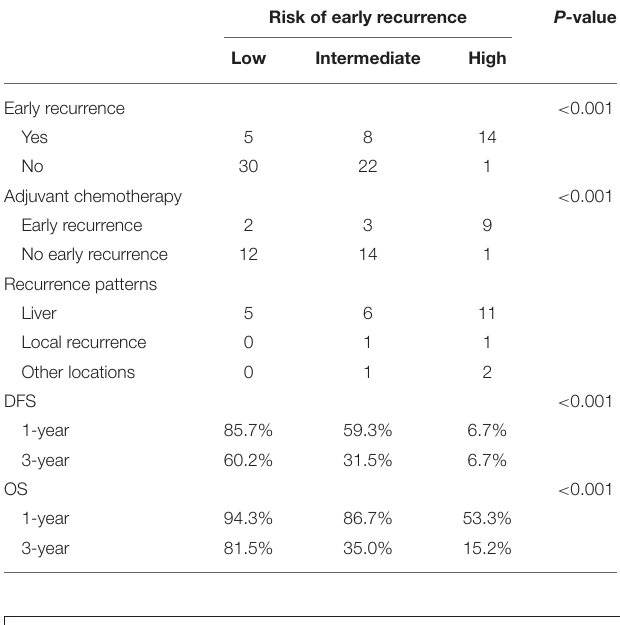
TABLE 4 | Recurrence patterns and 1-, 3- DFS/OS of different groups.